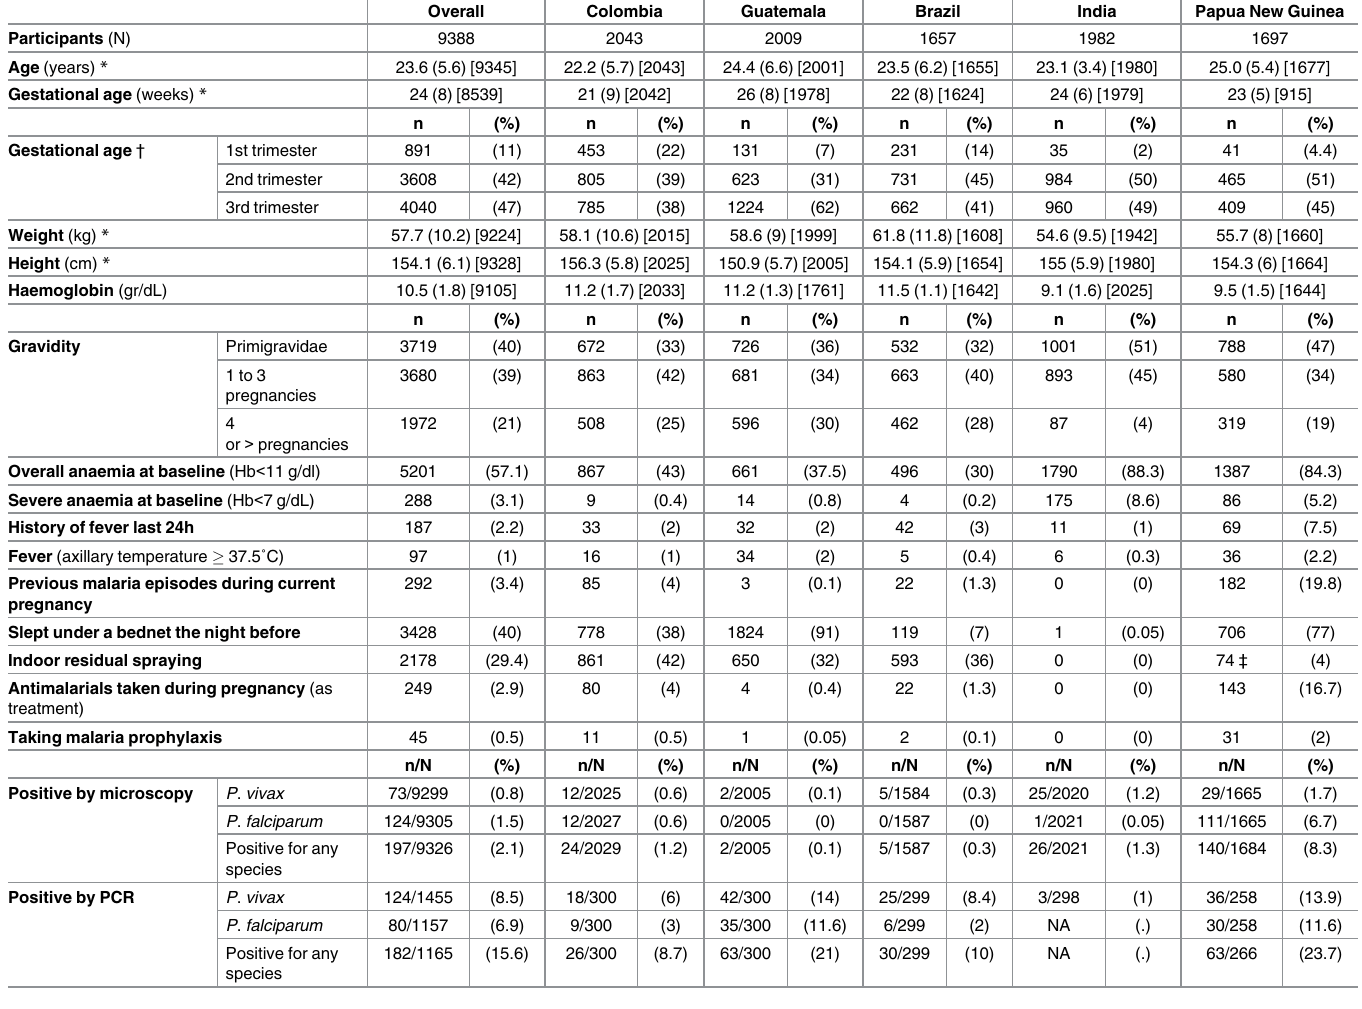
Table 2. Baseline characteristics of study women at